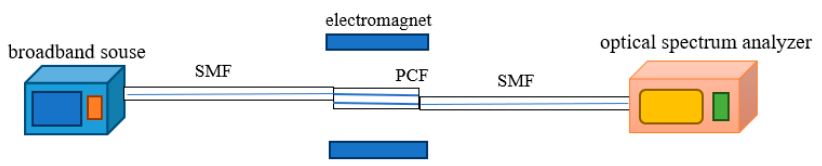
Figure 2. The experimental setup of the magnetic field sensor.